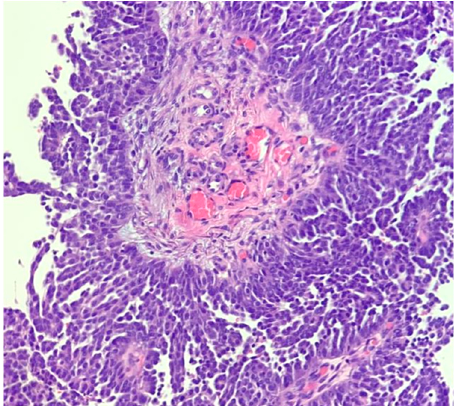
Figure 4. Low-grade serous carcinoma, micropapillary (medusa-like) architecture (hematoxylin-eosin; x100). ×